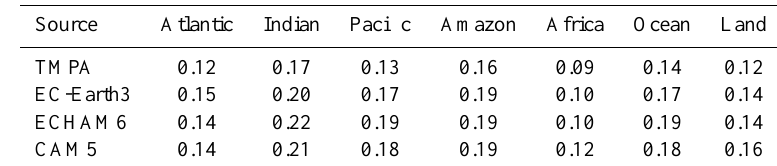
Table 3. Area-weighted mean RR [mmh − 1 ] for the regions depicted in Fig. 1 plus those of the merged ocean and land regions. All data are interpolated to a 1 ◦ grid.